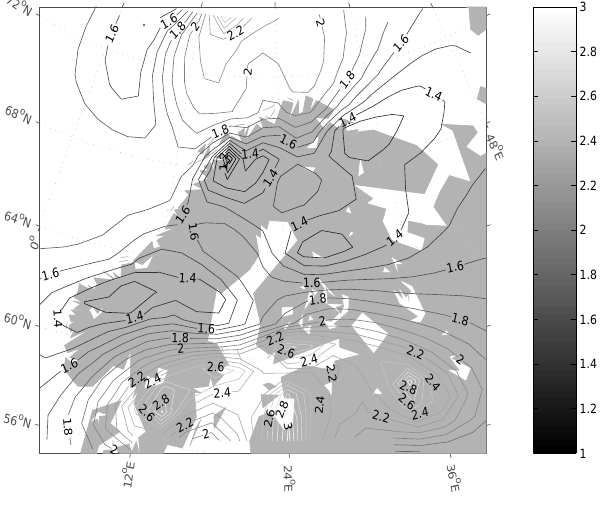
Fig. 8. Ionospheric equivalent currents ( J tot ) determined from the total modeled magnetic field. Magnetic field data from the con- tinental IMAGE array locations for time 01:55 UT are used (see Fig. 6). The maximum current amplitude is indicated in the title of the figure.